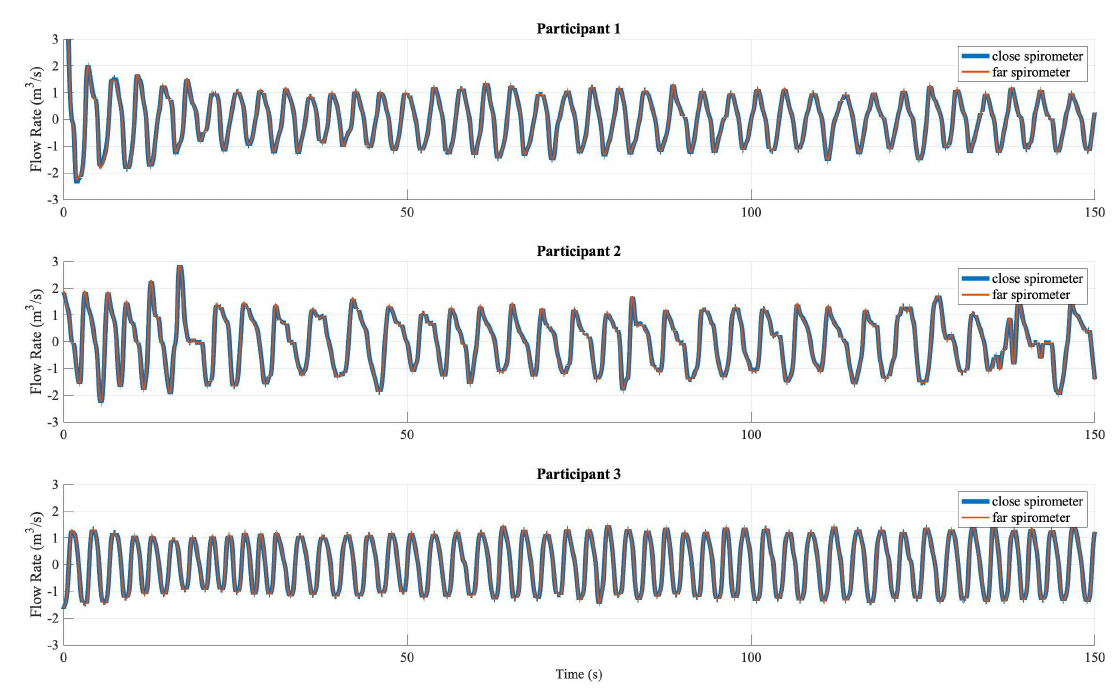
Figure 6. The flow rate data from both spirometers overlapped in The spirometer-to-spirometer (S2S)